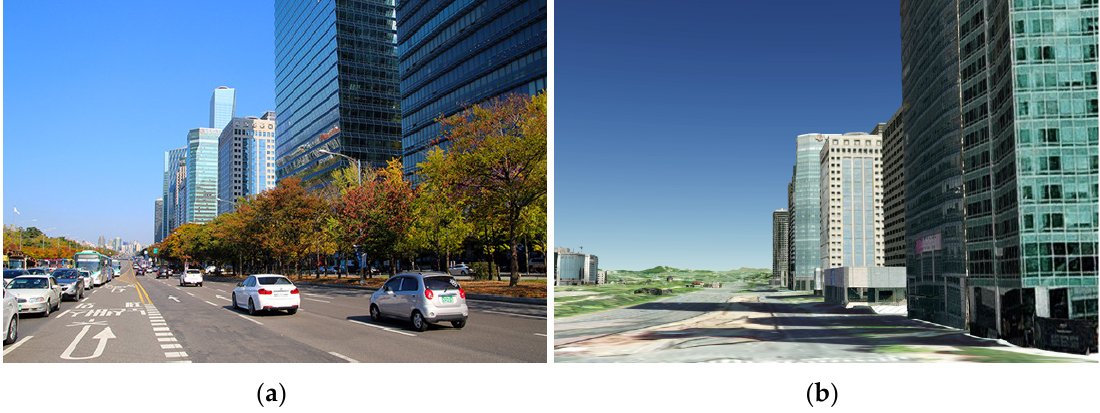
Figure 2. Differences between the real world and 3D city models: roads and buildings in ( a ) roads and the real world; ( b ) a 3D terrain and building model of Yeoui-daero, Yeongdeungpo-gu, Seoul, Republic of Korea.